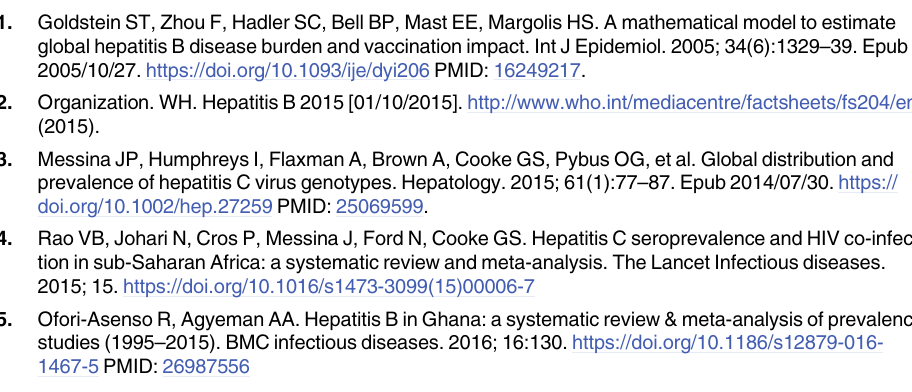
S1 Table. STROBE